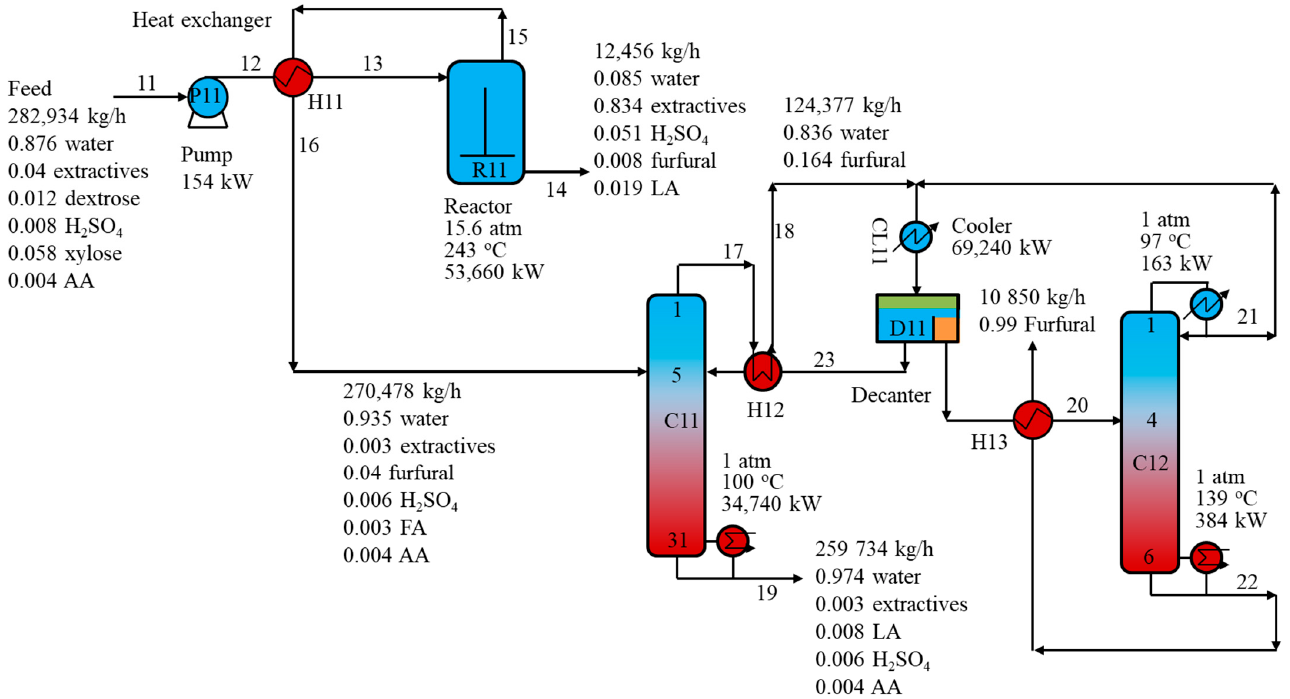
Figure 2. Schematic of the furfural reaction-distillation process.